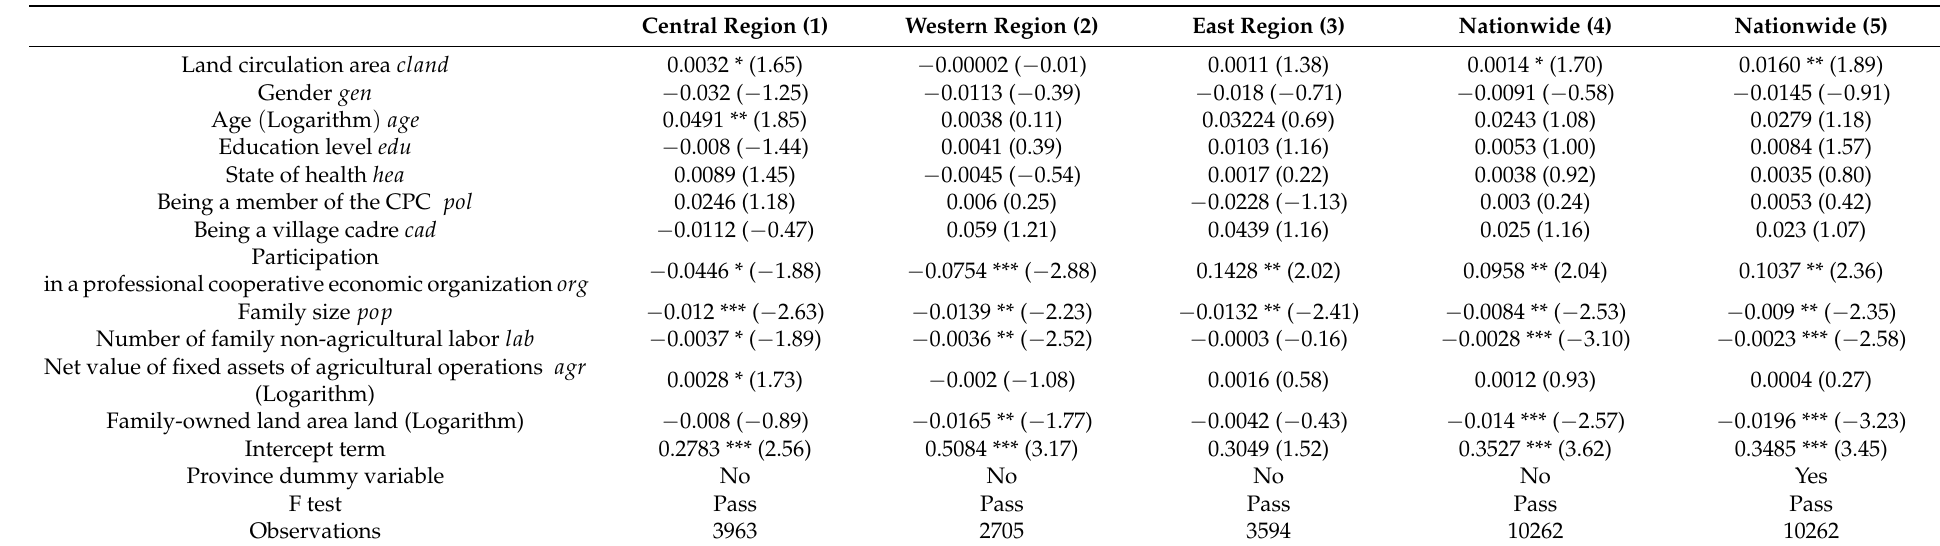
Table 2. Baseline estimation results of the impact of land circulation on the income gap of rural